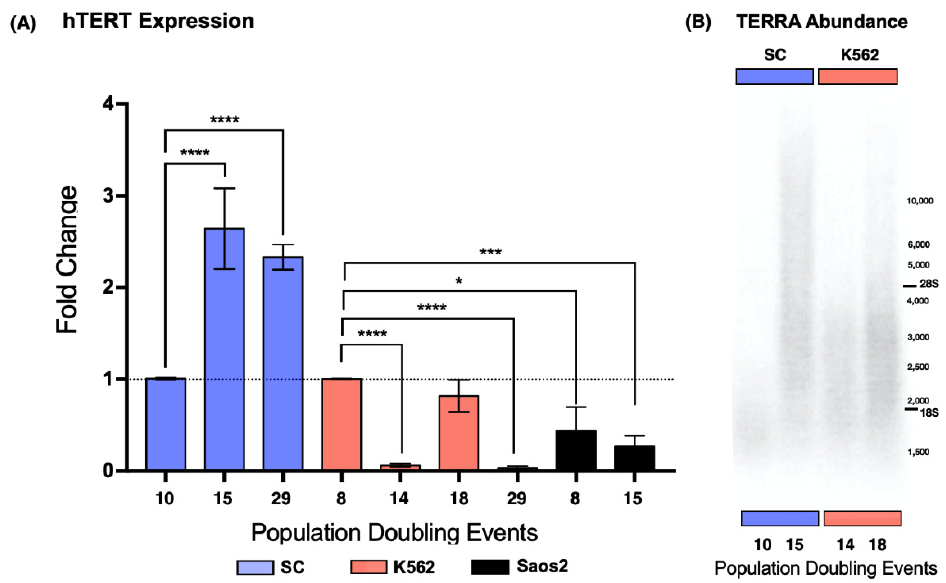
Figure 3. The expression of hTERT was recovered, and TERRA length increased in the SC cells. ( A ) Expression of hTERT in SC, K562, and Saos2 cells at different passages. hTERT showed increased and stable expression in SC cells. Fluctuating expression of hTERT was found in K562 cells. In Saos2 cells, hTERT expression remained significantly lower than that in myelogenous cell lines. Data were analyzed using ANOVA and Tukey ’ s multiple comparisons test. Adjusted p value < 0.0001 (****), = 0.0006 (***), = 0.0234 (*). ( B ) Northern blot analysis of TERRA abundance in the SC and K562 cell lines at different passages. There did not appear to be an increase in the global amount of TERRA in any of the sampled passages. However, there was an increase in the size of the lncRNA when hTERT expression was elevated in the SC cells (15 PDs) and in the K562 cells (18 PDs).